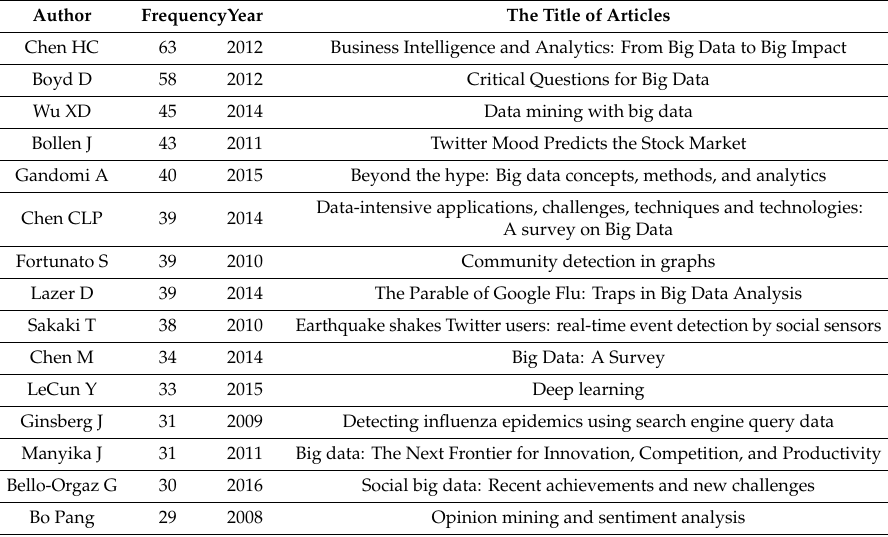
Figure 6. Knowledge map of co-citation literature in SMBD. Table 5. The first 15 pieces of co-citation literature in SMBD.